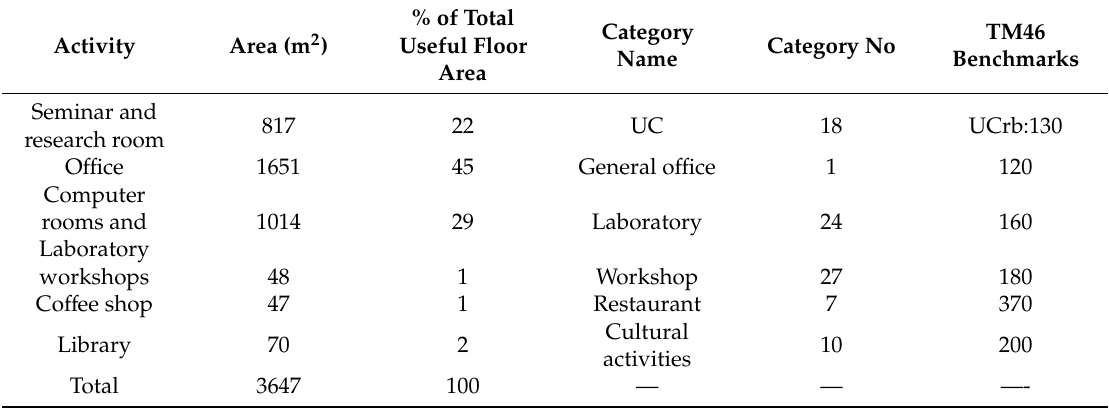
Table 2. Mixed activities value in the Aras An Phiarsaigh